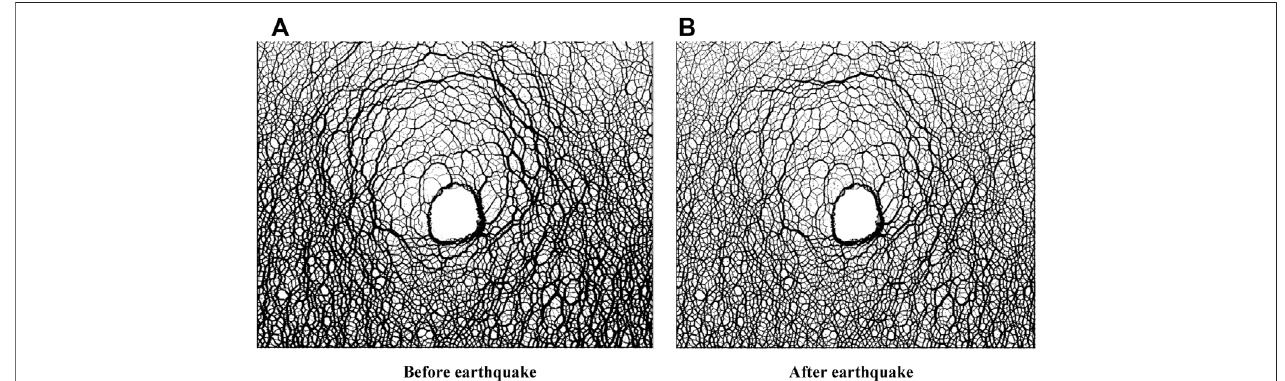
FIGURE 2 | Force chain pattern of 15 m deep tunnel. (A) Before earthquake. (B) After earthquake.